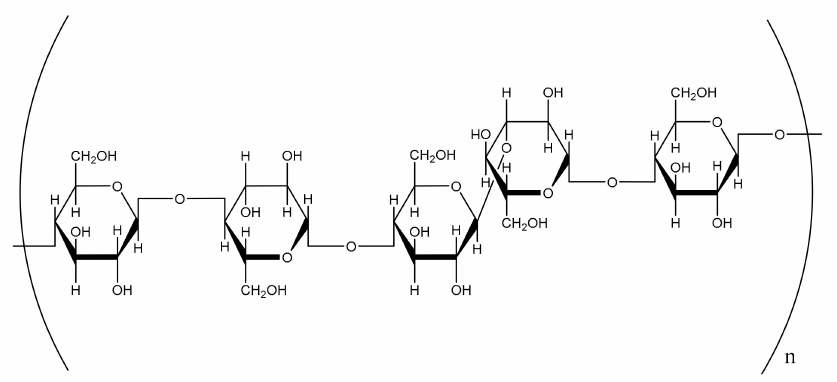
Figure 3. Structure of cereal β